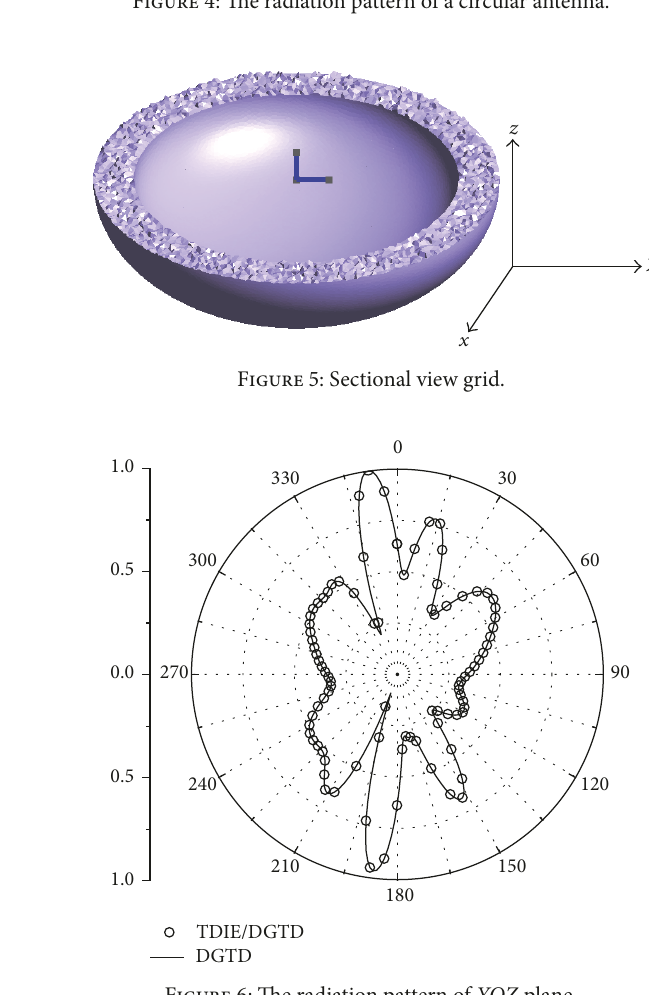
Figure 6: The radiation pattern of YOZ